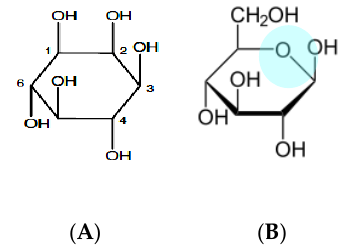
Figure 1. Example of a molecular structure of cyclitol ( A ) and sugar ( B ) [1].